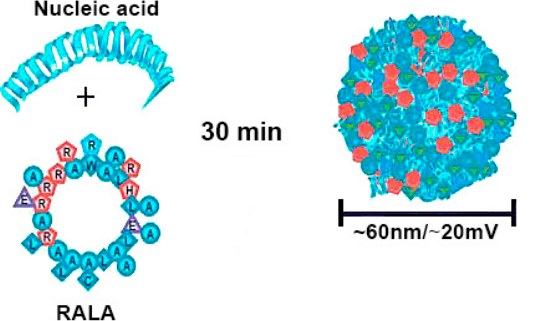
Figure 7. Schematic illustration of RALA / pDNA peptiplexes formation. Reproduced from [114], with permission. Copyright: 2018 Elsevier.